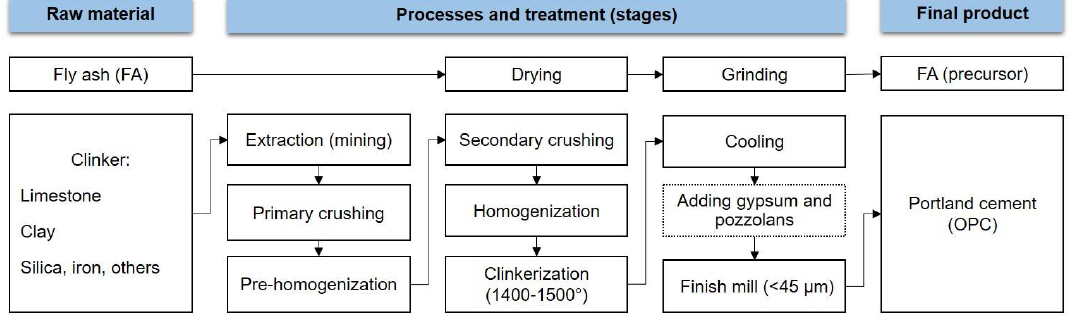
Figure 14. Processes and treatment (stages) of fly ash (FA) vs. Portland cement (OPC).